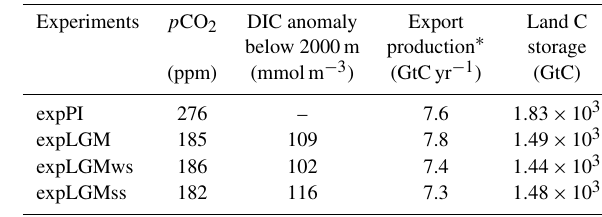
Table 3. Biogeochemical properties of the model states (the last 50- year average) in this study. For DIC, the anomaly is globally aver- aged over the depths of more than 2000m and shows the difference between each of the LGM simulations and